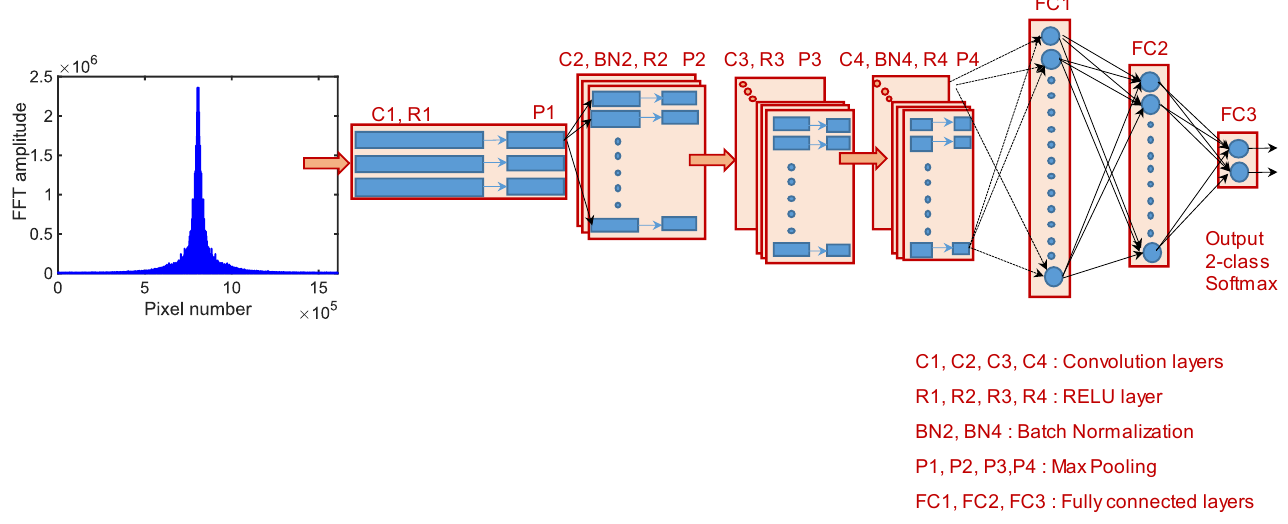
Figure 2. Architecture of 1D discrete Fourier transform (DFT) convolutional neural network (CNN) [58].